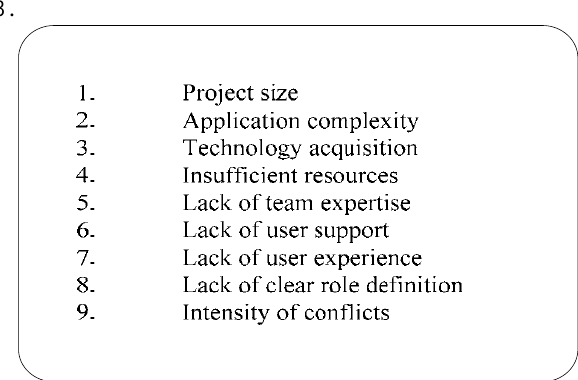
Figure 3: Jiang and Klein’s ‘top nine’ list of software risk items. (Jiang & Klein,